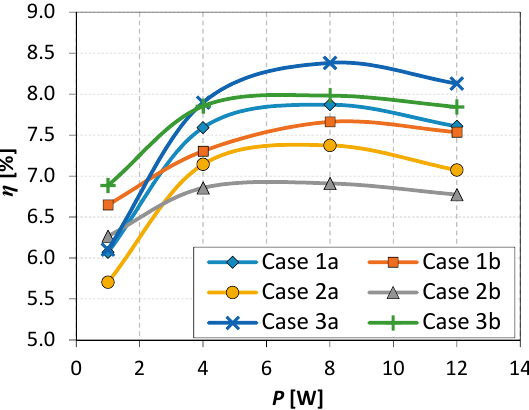
Figure 7. The energetic efficiency of SJA as a function of power at the resonance frequency.